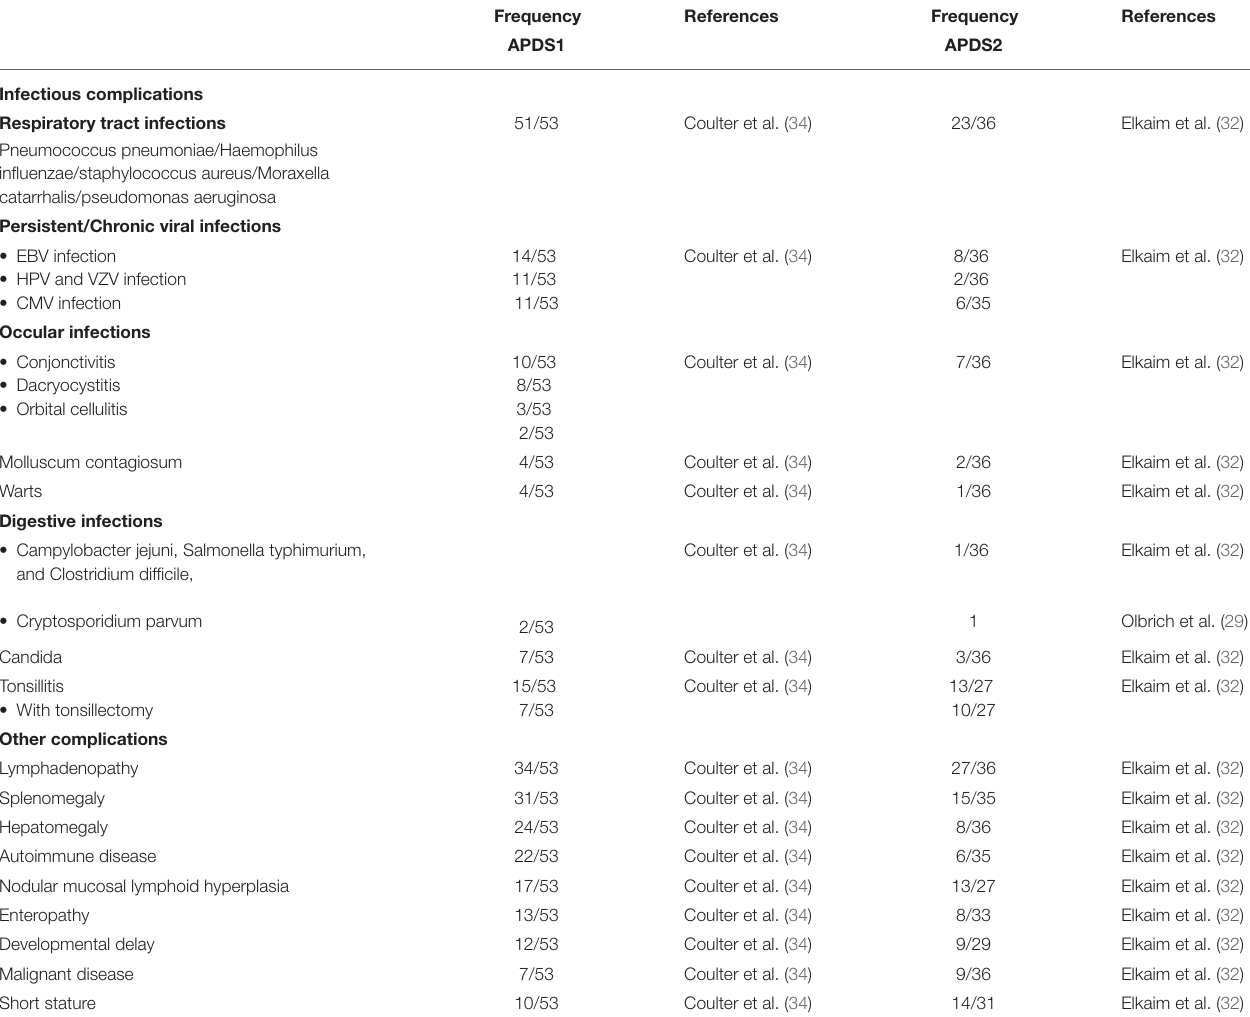
TABLE 1 | Clinical phenotype and infectious complications in APDS